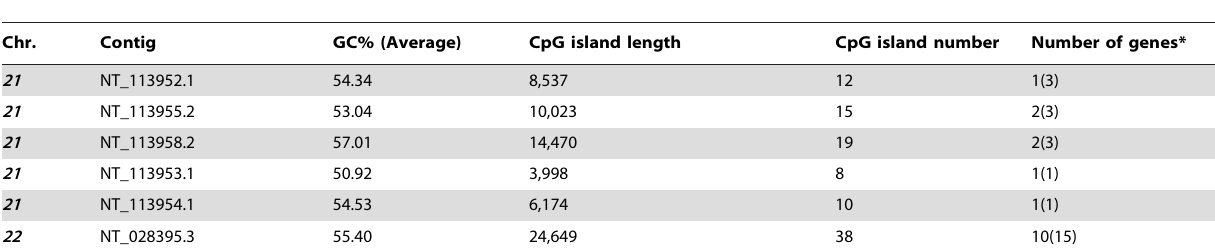
Table 2. Number of CpG islands located in gene regions identified with CPSORL.